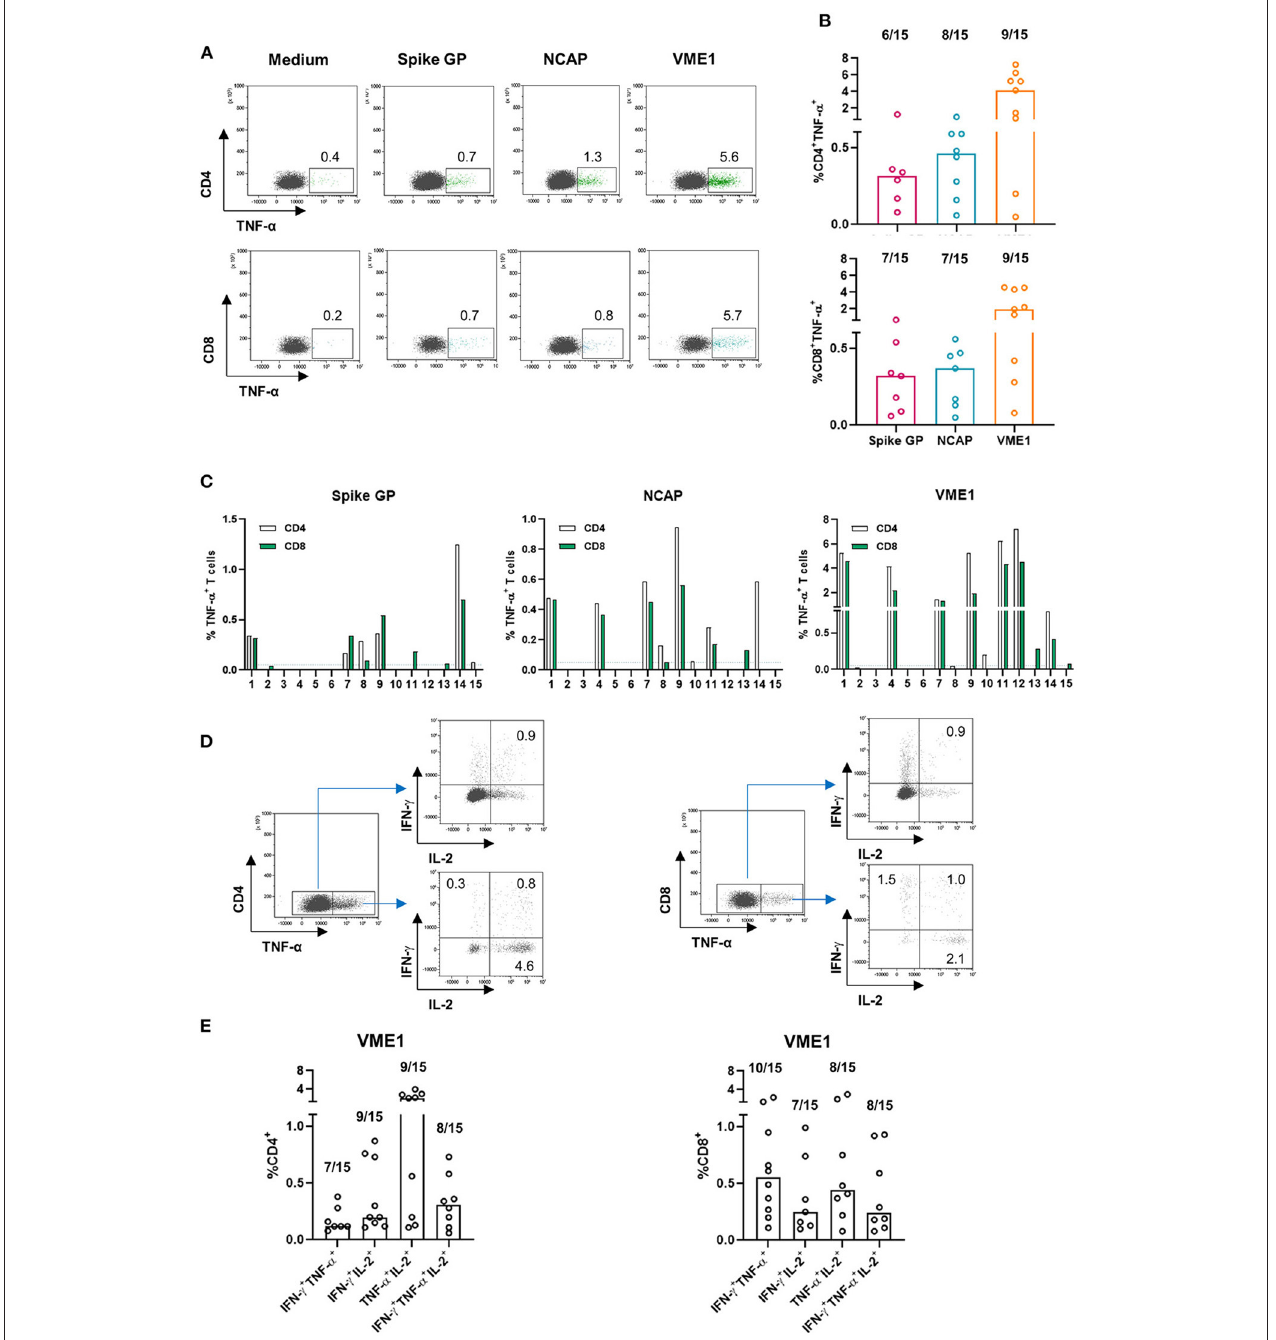
FIGURE 2 | SARS-CoV-2-specific T cells are poly-cytokines producing cells. PBMC were subjected to an overnight stimulation using PepMix peptide pools and analyzed by flow cytometry using intracellular staining for IFN- γ , TNF- α and interleukin-2 (IL-2) cytokines gating on CD4 and CD8T cell populations ( n = 15). (A) Dot plots are representative of TNF- α secretion by CD4T cell specific for the spike glycoprotein, NCAP and VME1 protein for one high responder CPD (left panel) and presence of CD4T cell responses specific for the three SARS-CoV-2 proteins based on TNF- α secretion in 15 CPD (right panel). (B) Dot plots are representative of TNF- α secretion by CD8T cell specific for the spike glycoprotein, NCAP and VME1 proteins for one high responder CPD (left panel) and presence of CD8T cell responses specific for the three SARS-CoV-2 proteins based on TNF- α secretion in 15 CPD (right panel). (C) Presence of CD4 and CD8T cell responses specific for the three SARS-CoV-2 proteins based on TNF- α secretion among 15 CPD. (D) Dot plots are representative of CD4 and CD4 poly-cytokines producing T cells specific for VME1 protein in one high responder CPD. (E) Presence of poly-cytokines producing T cells specific for the three SARS-CoV-2 proteins based on IFN- γ , TNF- α